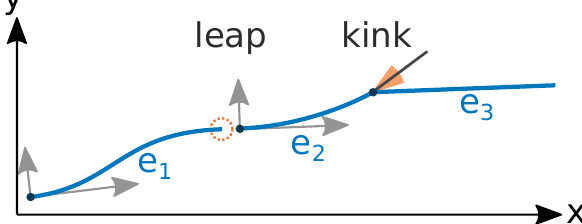
Figure 6. Plan view of concatenated geometry elements ( e 1 - e 3 ) forming a defective reference line for a single